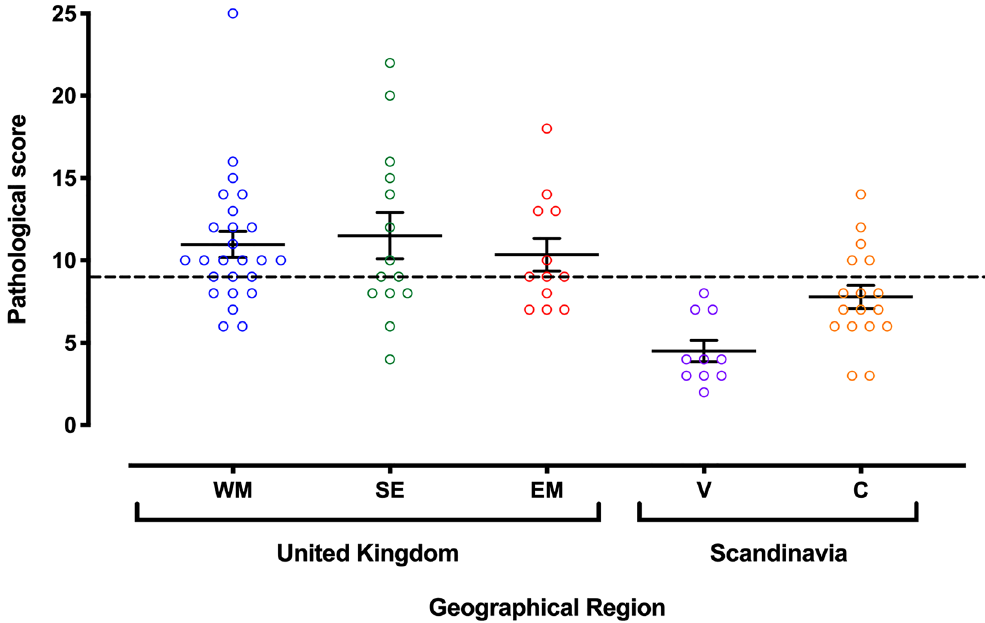
Figure 2. Regional differences in histopathology score of dog testes collected from five geographical regions. Each point represents a different testis from a specific geographical region; West Midlands, UK (WM: blue), South East, UK (SE: green), East Midlands, UK (EM: red), Vantaa, Finland (V: purple) and Copenhagen, Denmark (C: orange). Dotted line represents a base line histopathological abnormality characteristic of a normal testis calculated from the median value of all histopathological scores [n = 77]. Pathology score values above this line were considered abnormal. Error bars and lines denote mean ± 1 S.E.M. Figure was created using GraphPad Prism version 8.0 for Mac, GraphPad Software, California, USA (https:// www. graph pad. com).